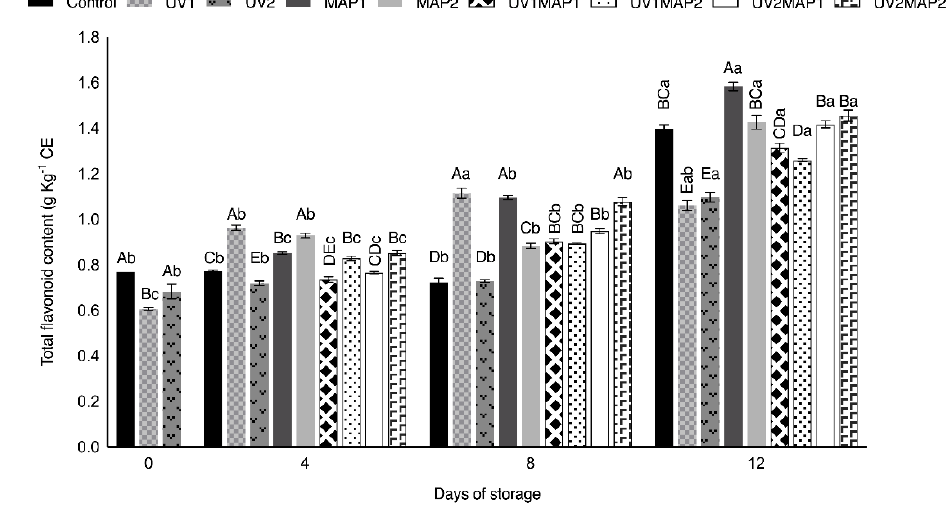
Figure 6. Total flavonoid content (TFC) of raspberries stored in air (control), treated with UV-C radiation (UV1 or UV2), packaged in MAP (MAP1 or MAP2) and their combinations during 12 d of storage. Values represent mean ± standard deviation ( n = 3). Lower case letters indicate significant differences ( p < 0.05) among days within the same batch. Capital letters indicate significant differences ( p < 0.05) among batches within the same day.